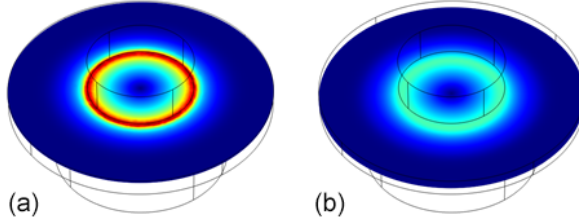
Figure 2. Radial strain in the spacer disk of the screw head 0.1mm below the surface (a) and 0.5mm below the surface (b) . The maxi- mum strain is higher and the distribution more distinct towards the surface. Low strain is indicated by deep blue color and high strain by red color,